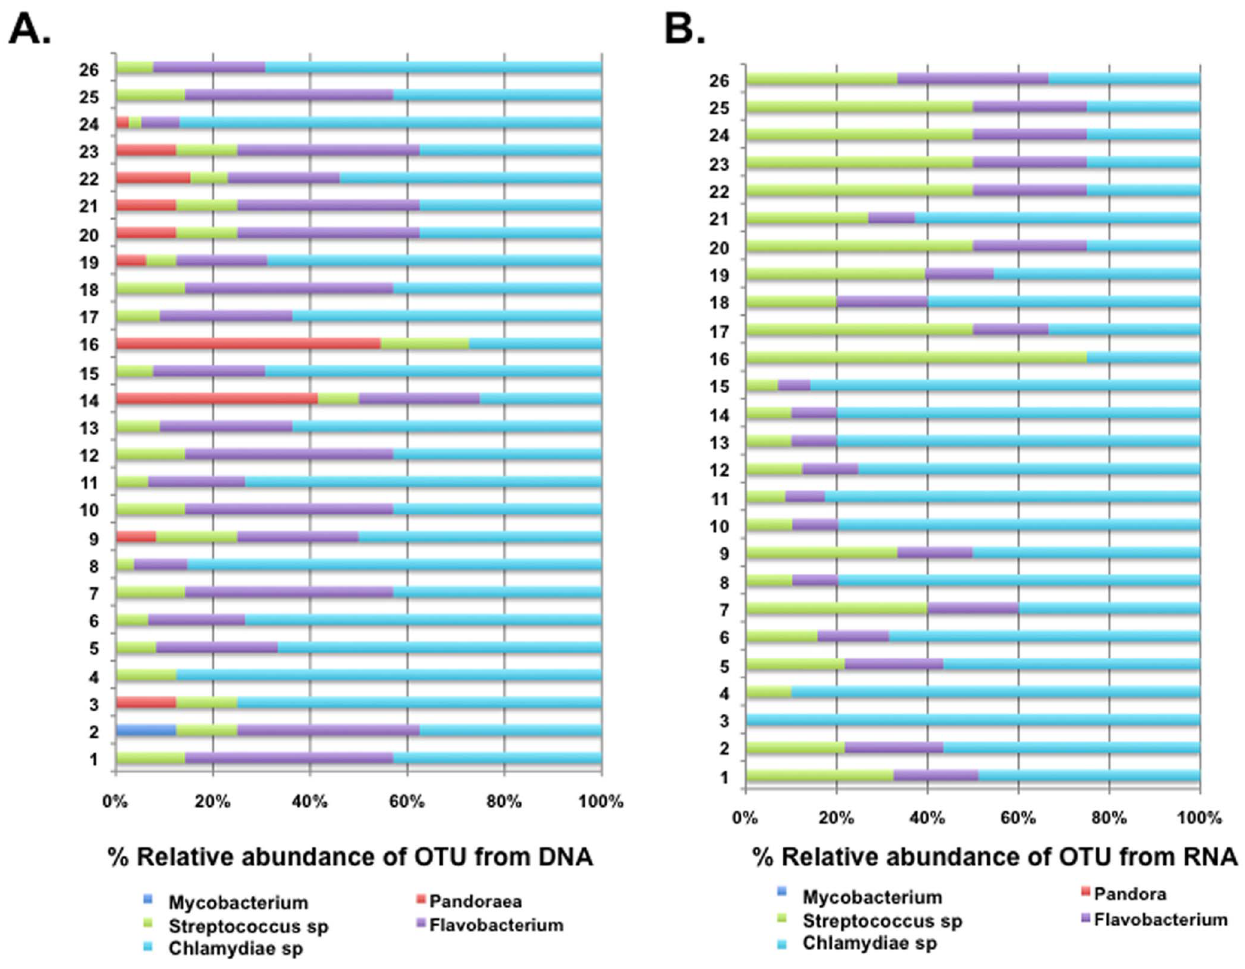
Figure 3. Prevalence of emerging CF bacterial pathogens among sputum samples from CF patients suffering exacerbation. Percentage of sequences from DNA-based (A) or RNA-based (B) approaches are delineated. The coloured segments of each bar represent the proportion of reads mapping to different bacterial orders.